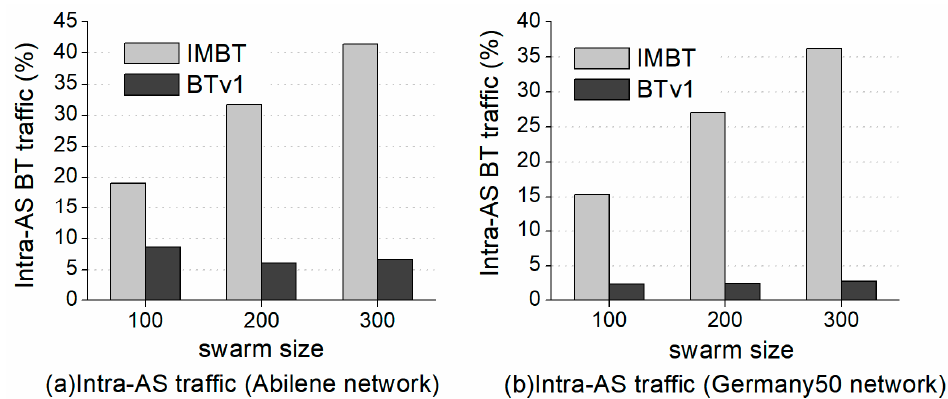
Figure 8. ( a ) is intra-domain traffic of IMBT and BTv1 under different swarm size of Abilene, and ( b ) is intra-domain traffic of IMBT and BTv1 under different swarm size of Germany50,.